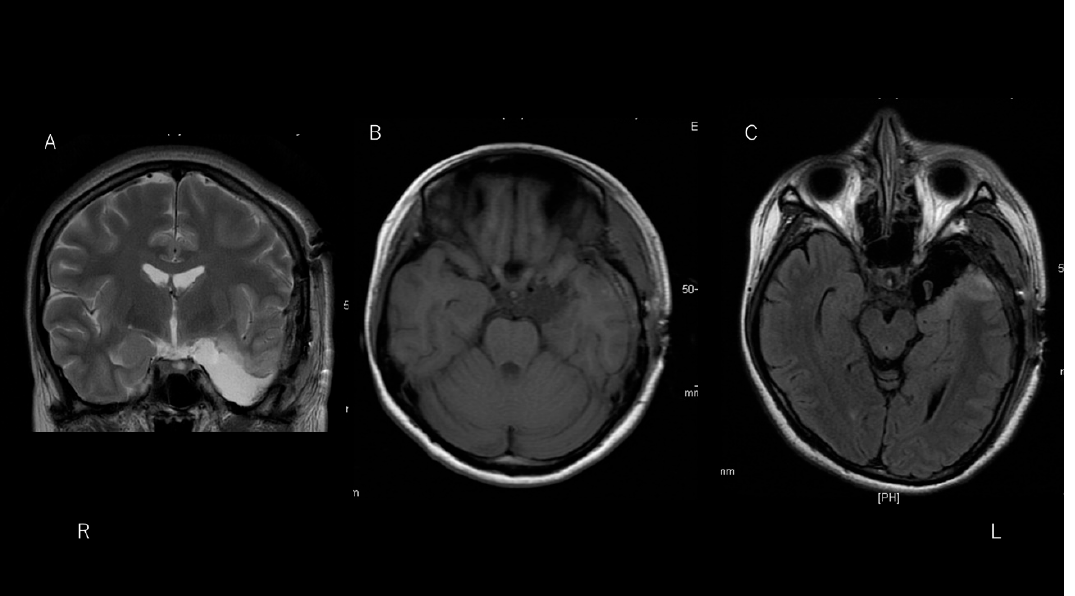
Figure 4. T2-weighted imaging ( A ) and T1-weighted imaging ( B ) reveal total removal of the lesion in the left temporal region. Fluid-attenuated inversion recovery imaging ( C ) of a hippocampus slice shows removal of the anterior temporal lobe tip, preserving the hippocampus.